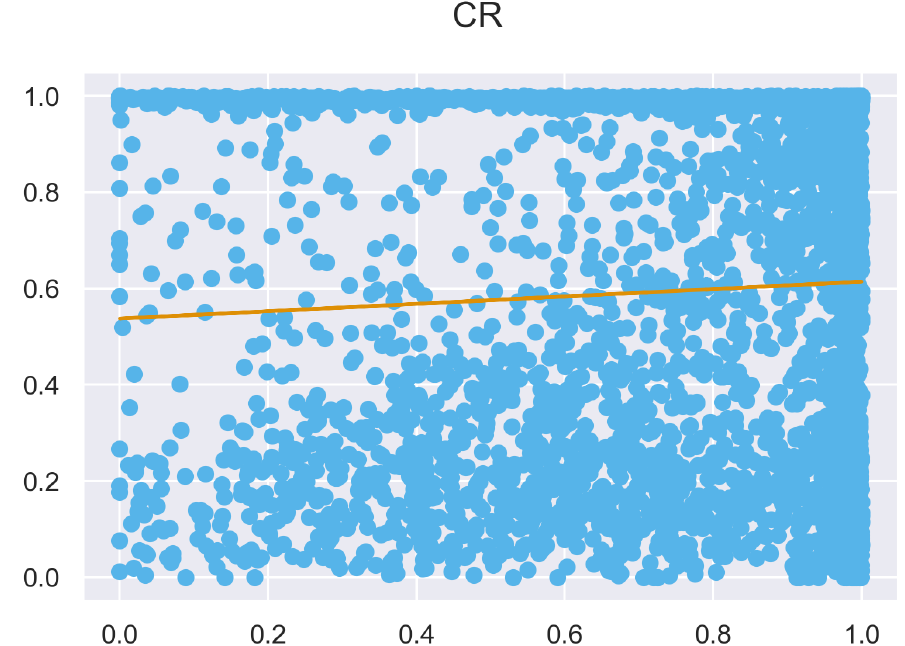
Figure A28. ULS and TLS CR regression at 1m grid size.